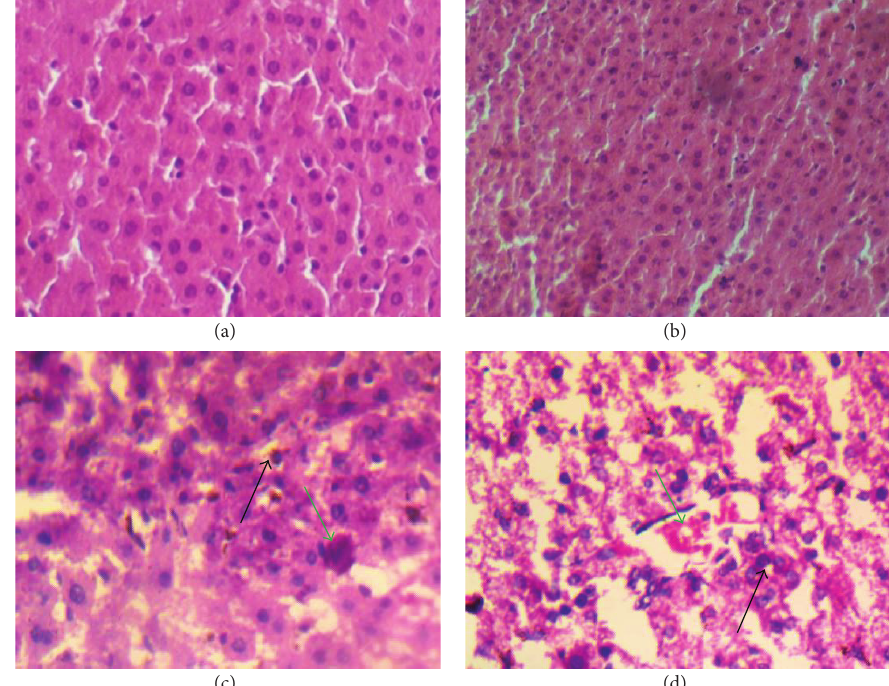
Figure 4: Influence of 2,5-HD on liver morphology after treatment for 21 consecutive days in rats. Representative photomicrographs of liver samples of rats in control (a) and 0.25% 2,5-HD (b) appear normal whereas mild central venous congestion (green arrow) and cellular infiltration (black arrow) by neutrophils were identified in 0.5% 2,5-HD (c) and 1% 2,5-HD (d).